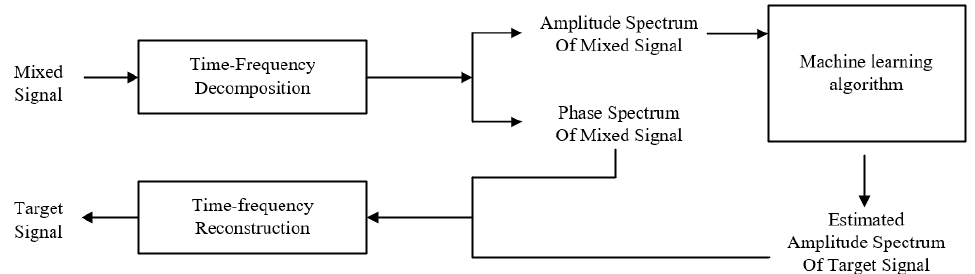
Figure 1. The limitation of the frequency-domain music-separation method.